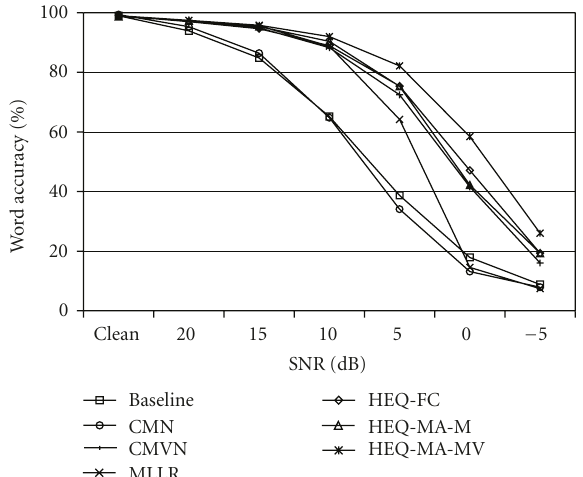
Figure 2: Recognition results on the Korean POW data at various SNR conditions by the baseline speech recognizer, CMN, CMVN, MLLR, HEQ-FC, HEQ-MA-M (mean-only adaptation), and HEQ- MA-MV (mean and variance adaptation)